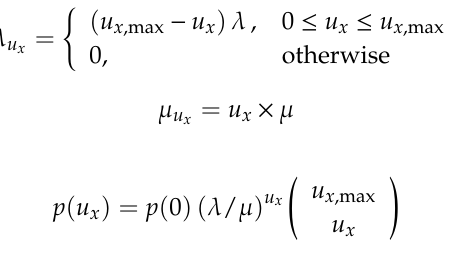
Figure 4. Traffic in-progress state diagram for UEs of an MNO x per 3-dimensional (3D) building. Figure 4. Tra ffi c in-progress state diagram for UEs of an MNO x per 3-dimensional (3D) Denote and respectively the birth rate and death rate such that the following holds [15,16].